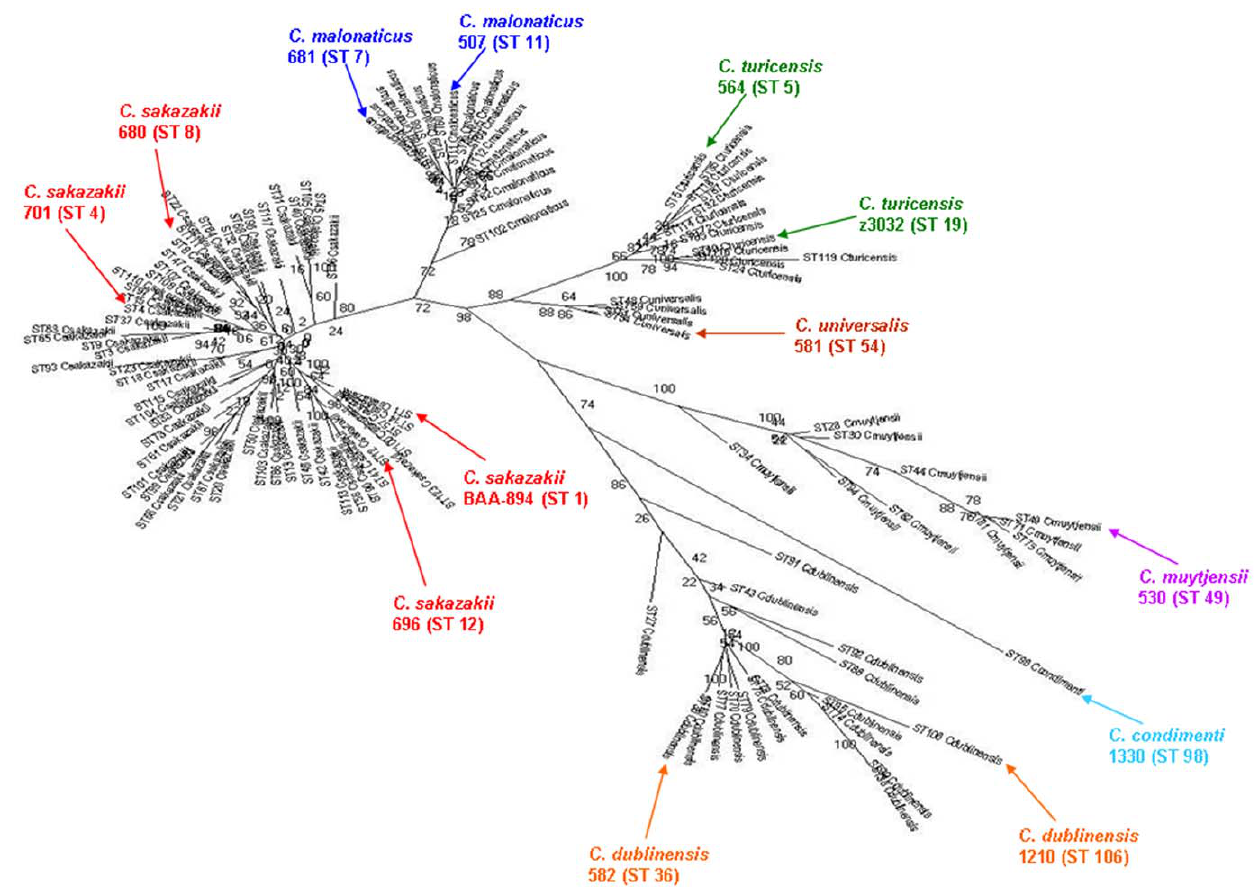
Figure 2. Maximum Likelihood tree based on the concatenated sequences (3,036 bp) of the seven MLST loci. The tree is drawn to scale using MEGA, with 1000 bootstrap